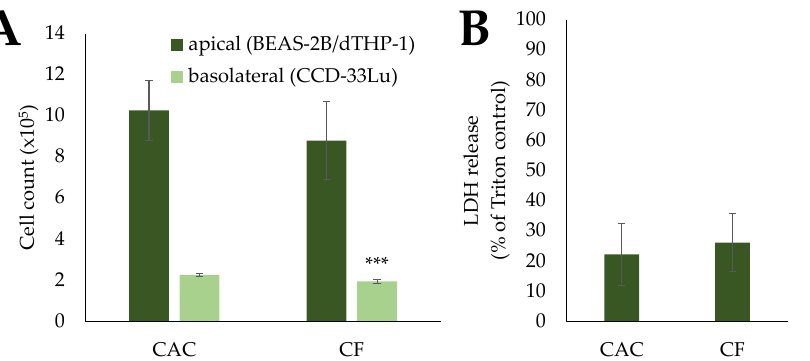
Figure 3. Assessment of cytotoxicity in BEAS-2B/dTHP-1/CCD33-Lu triple-cultures after exposure to mechanically treated CF (mCF). CCD-33Lu cells were seeded on the basolateral side of inverted inserts on the basolateral side of the membrane with a density of 9 × 10 4 /cm 2 . After 1 h, the inserts were inverted, and BEAS-2B cells were seeded onto the apical side of the membrane with a density of 2 × 10 5 /cm 2 . After 4 h, dTHP-1 cells (3.9 × 10 4 /cm 2 ) were seeded on top of the BEAS-2B cells. On the next day, triple-cultures were exposed to CF samples with average surface doses of 7.00 ± 1.25 µg/cm 2 mCF for 1 h and post-incubated for 23 h. Clean air controls (CAC) were treated analogously. Cells were harvested for the determination of cell count ( A ). The supernatants were analyzed for LDH release ( B ), which is depicted relative to the Triton control (100%). The mean values ± SD of at least three independent experiments performed in duplicates are displayed. Statistical analysis was performed to assess differences between treated and untreated cells using Student’s t -test: *** ( p ≤ 0.001).